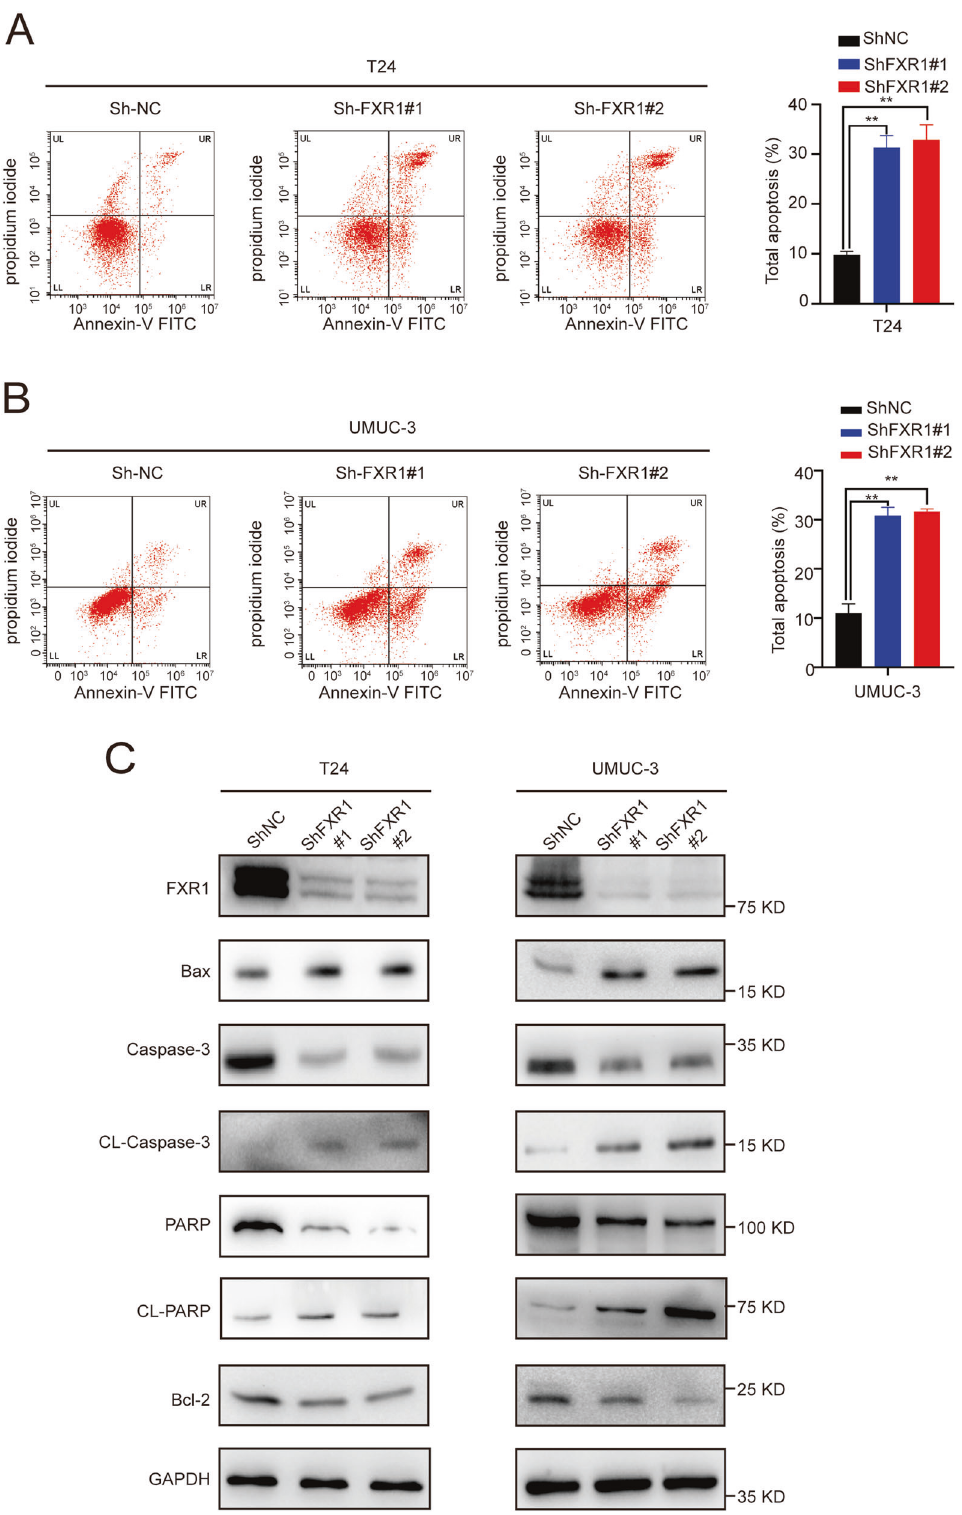
Fig. 3 FXR1 inhibits the apoptosis of UCB cells. A , B Flow cytometry image of control or FXR1 knockdown UCB cells as indicated. Data are presented as the mean ± SD, n = 3, ** p < 0.01 (Student ’ s t -test). C Western blot showing the expression of apoptosis-related proteins in control or FXR1 knockdown UCB